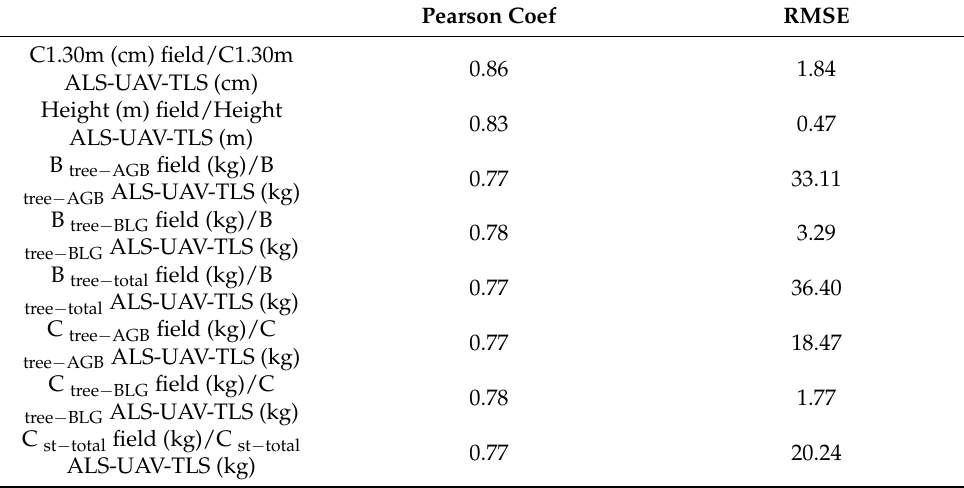
Table 5. Relationship between dendrometric parameters (H, C1.30m), biomass, and carbon stock (aboveground, belowground, and total) measured and estimated with field measurements and from UAV-ALS-TLS data (Pearson Coefficient and RMSE).